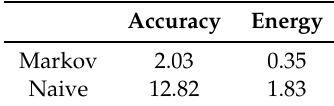
Table 2. The average prediction error, made on predicting the energy consumption and classification accuracy for the naive and Markov chain model. The values are given in % with respect to the range of possible values for the accuracy and energy consumption (see Figure 2).